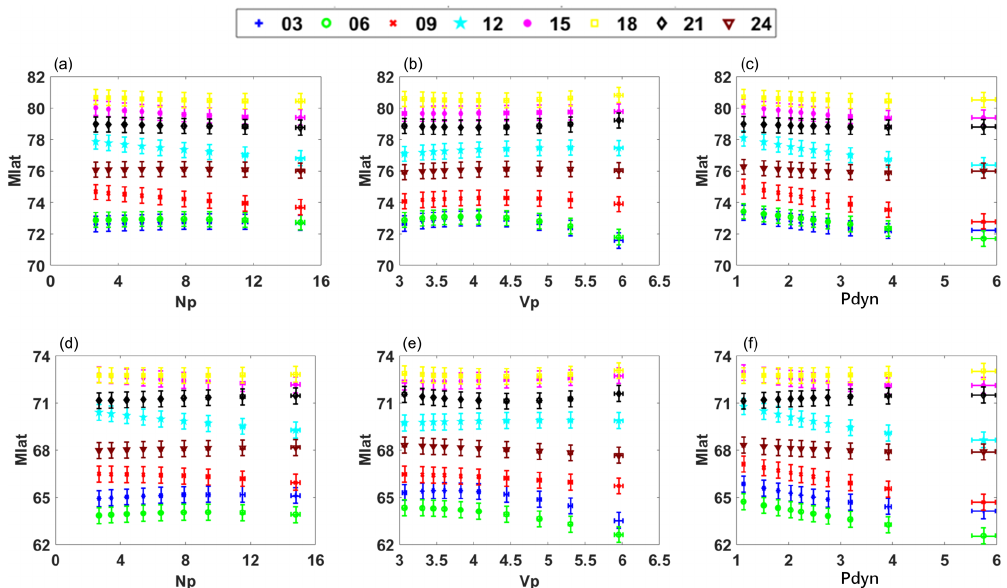
Figure 6. Responses of the magnetic latitudes of the poleward (a, b, c) and equatorward (d, e, f) boundaries to N p , P dyn , and V p respectively at 00:30, 00:60, 00:90, 12:00, 15:00, 18:00, 21:00, and